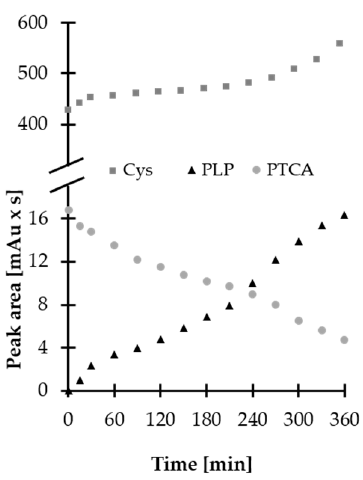
Figure 6. Stability of HPPTCA in human plasma spiked with the analyte (100 µmol L − 1 ) at room temperature, expressed as a peak area. Samples were processed according to previously published methods based on HPLC-UV [21,22].